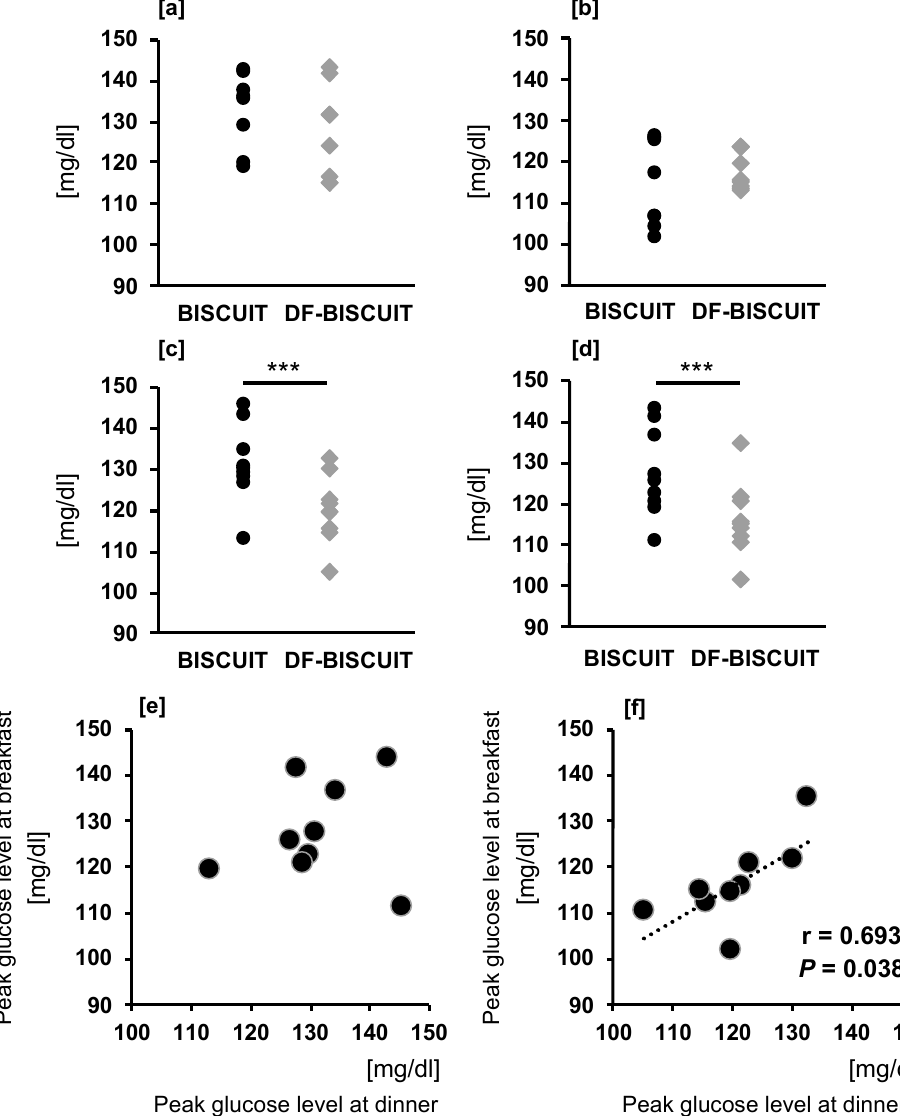
Figure 4. Peak glucose levels after lunch ( a ), after snack ( b ), after dinner ( c ), and after breakfast ( d ). *** p < 0.001 compared with level in the BISCUIT trial (paired t -test). The relationship between peak glucose level at breakfast and peak glucose level at dinner in the BISCUIT ( e ) trial and DF-BISCUIT ( f ) treatment. BISCUIT, regular snack; DF-BISCUIT, snacks with a rich dietary fiber content.